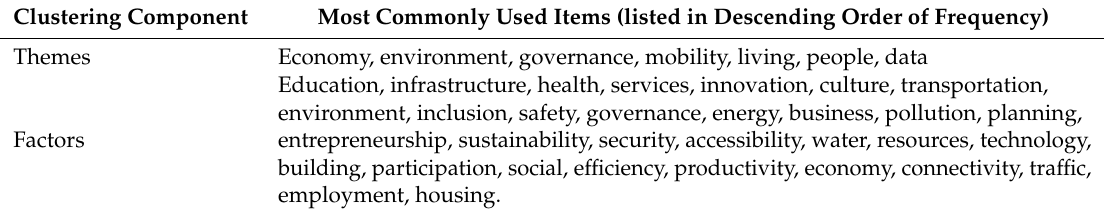
Table 4. The most commonly used themes and factors